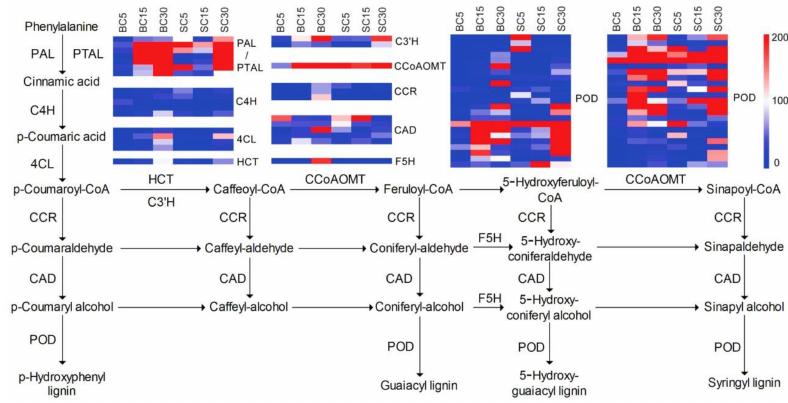
Figure 5. Expression patterns of the expressed genes assigned to lignin biosynthesis in the six D. sinicus transcriptomes: BC5, BC15, BC30, SC5, SC15, and SC30. Completed according to KEGG source record: ko00940. All metabolic enzymes predicted in the D. sinicus transcriptome are marked in the pathway. FPKM values range from 0 to 200. PAL: phenylalanine ammonia-lyase; PTAL: phenylalanine/tyrosine ammonia-lyase; C4H: cinnamate 4-hydroxylase; 4CL: 4-coumarate–CoA ligase; HCT: shikimate